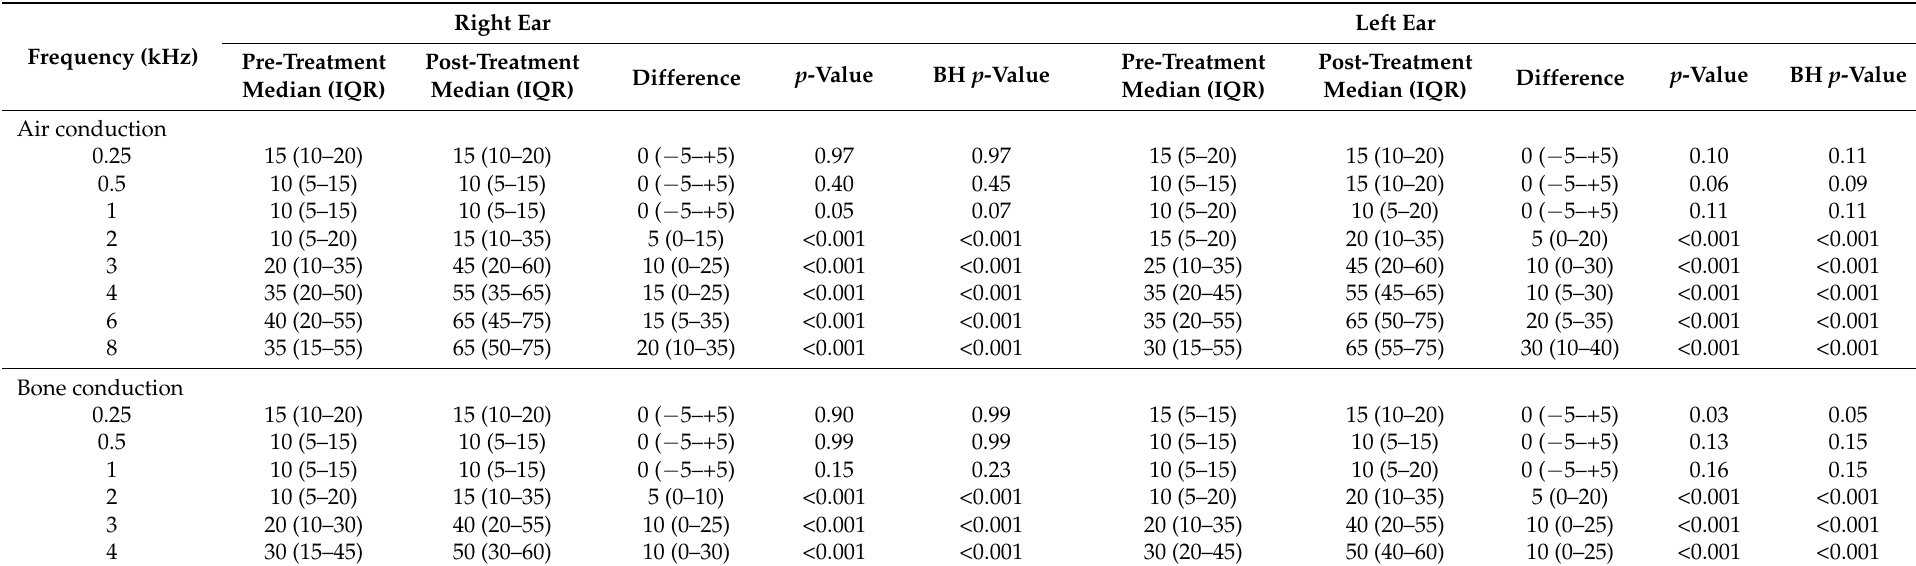
Table 2. Hearing thresholds for each frequency in pure tone